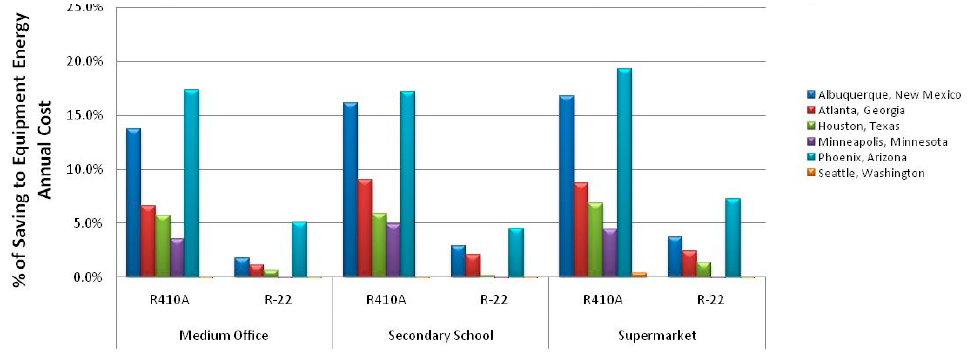
Figure 11. Percentage of energy savings due to pre-cooling relative to no pre-cooling at all ambient temperatures. Wet bulb efficiency = 0.9, equipment COP = 3.